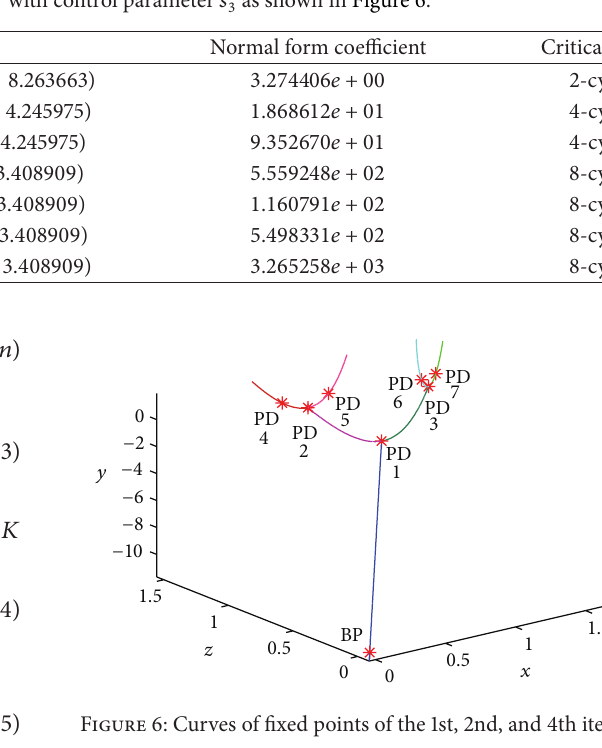
Table 3: Numerical continuation of 𝐸 1 with control parameter 𝑠 3 as shown in Figure 6.